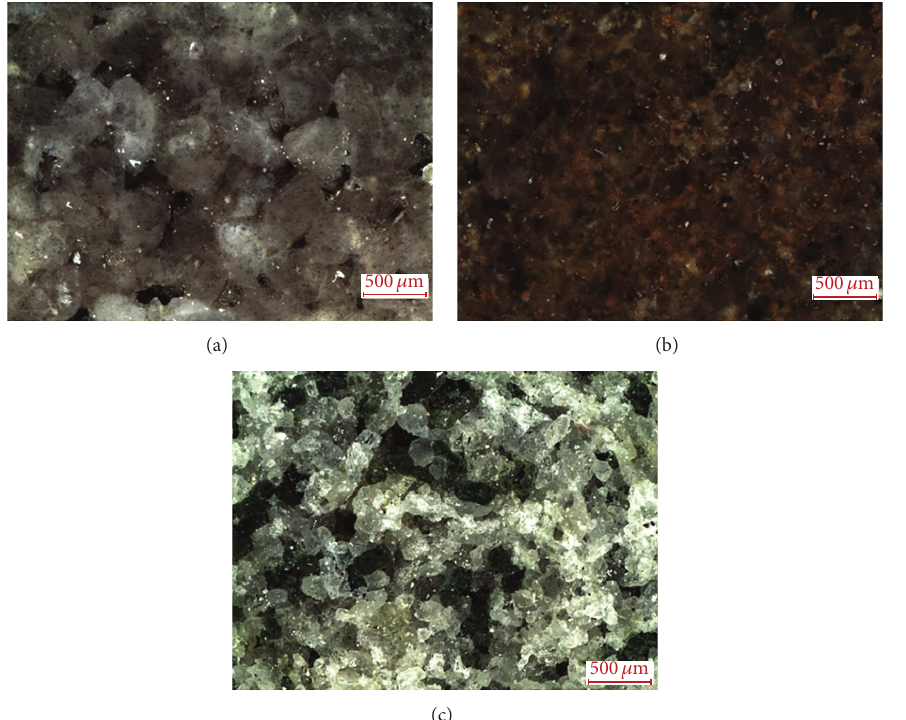
Figure 2: Microscopy images of investigated sandstones (SK—(a), SL—(b), and